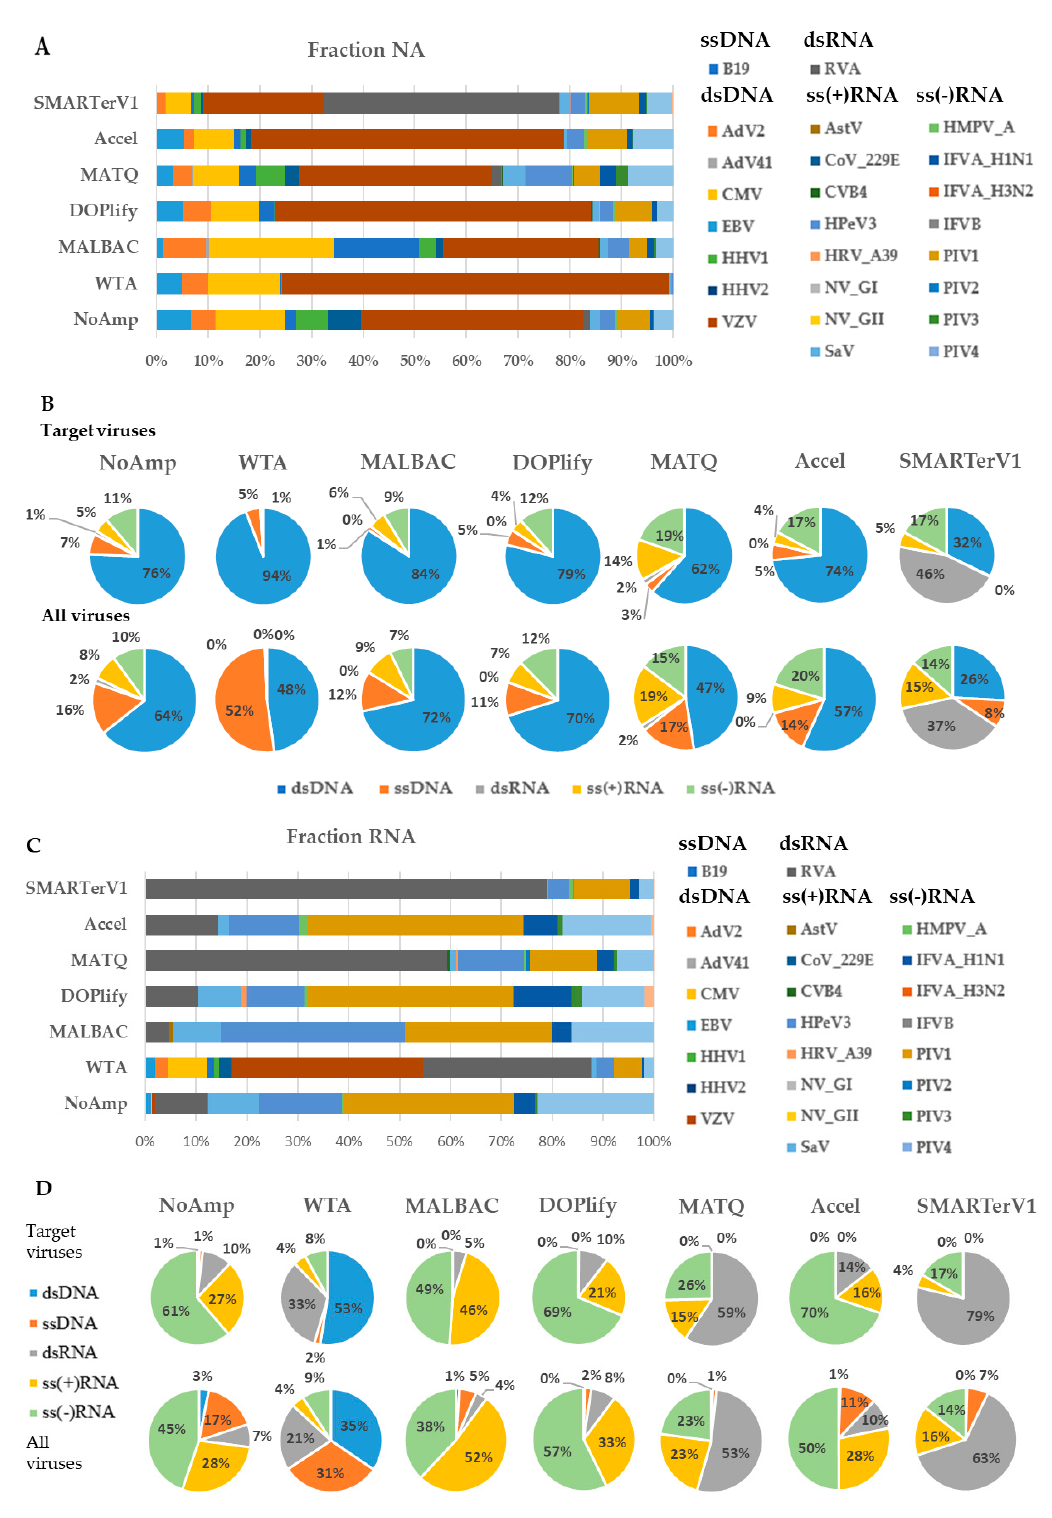
Figure 3. Proportion of spiked viruses (upper panels ( A , C )) and viral genomic groups (lower panels ( B , D )) in the VMRP based on the weighted contigs and singletons (WNCS). ( A , B ) In the NA fraction; ( C , D ) in the RNA fraction. Comparison of viral genomic groups is shown for target viruses (top) and for all viruses (bottom).